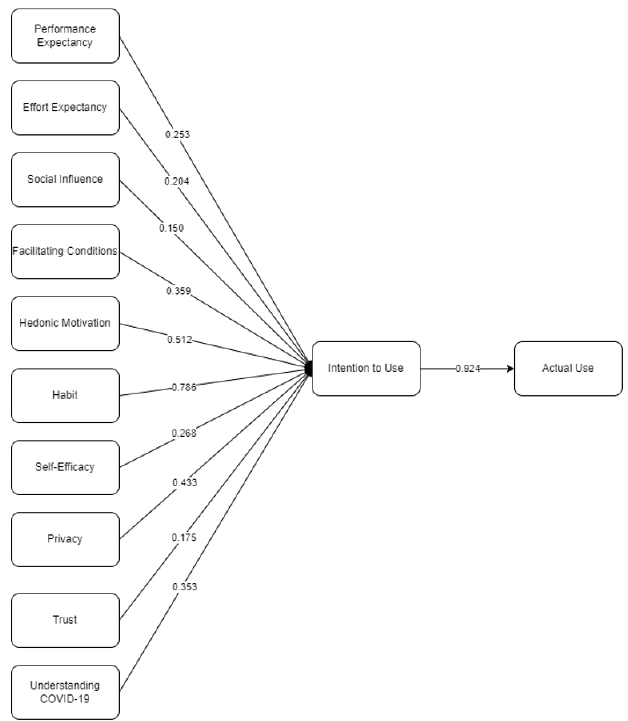
Figure 4. Final SEM for intention to use the MorChana mobile application. Table 4. Model fit.